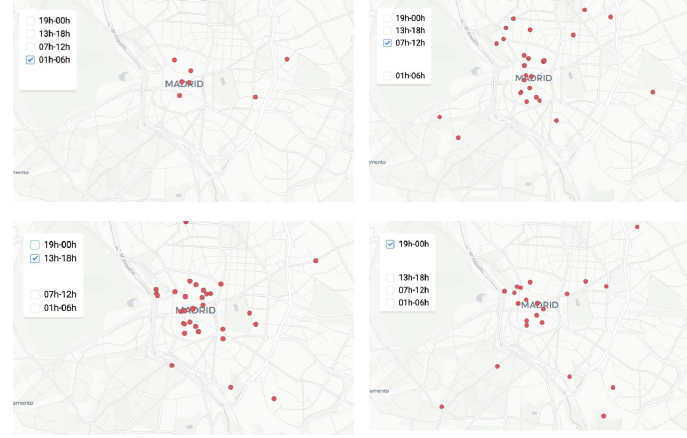
Figure 4. Distribution of the complaints by time intervals in Madrid.